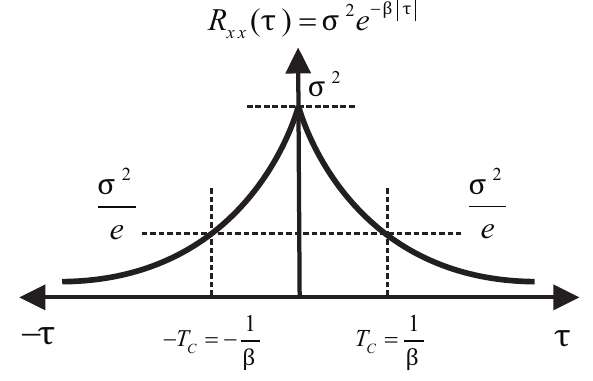
Figure 4. The autocorrelation function of the first order Gauss-Markov